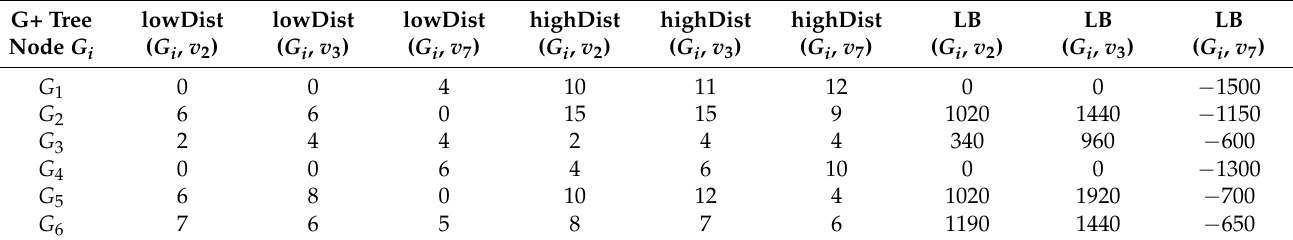
Table A13. lowDist , highDist , and LB of G + -tree